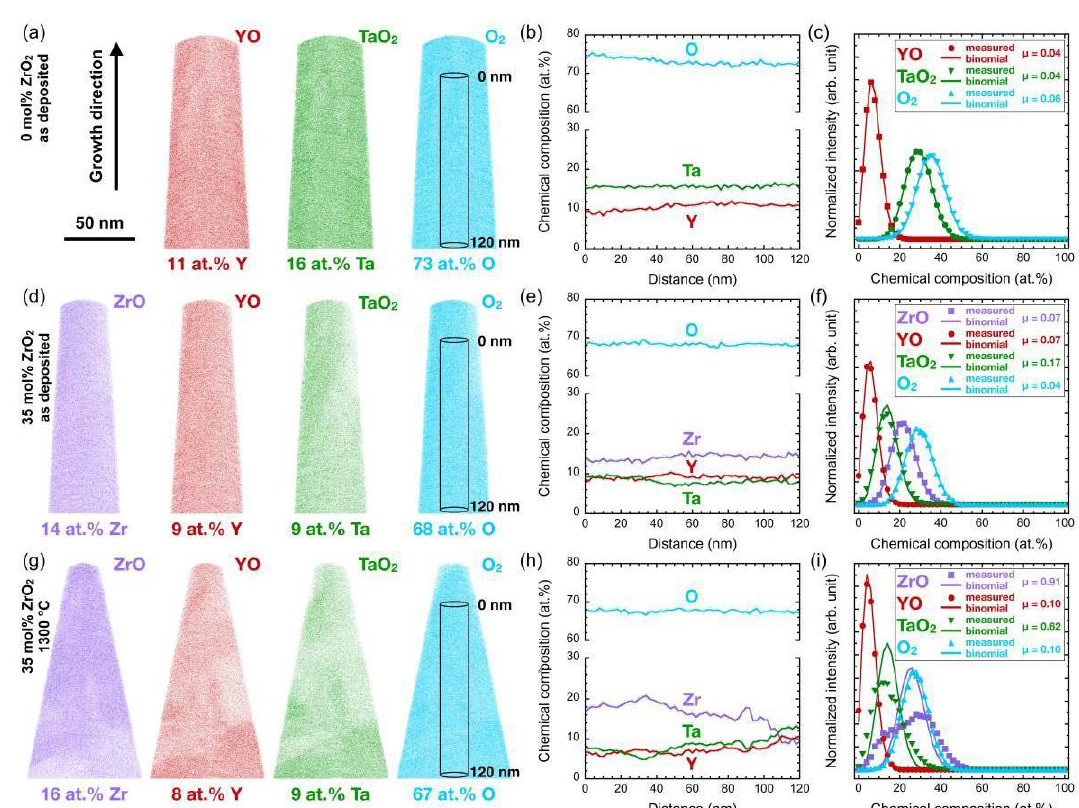
Figure 6. Spatially resolved chemical composition analysis by atom probe tomography (APT) of as-deposited samples with 0 mol% ZrO 2 ( a – c ) and 35 mol% ZrO 2 ( d – f ) as well as a sample with 35 mol% ZrO 2 annealed at 1300 °C ( g – i ); Reconstructions of molecular ions in ( a , d , g ) are provided as 20 nm slices with a length of 150 nm; Concentration profiles within cylinders indicated in ( a , d , g ) are shown in ( b , e , h ); Frequency distribution analyses with Pearson correlation coefficients µ are given in ( c , f , i ), and the measured distributions (data points) are compared to a random, binomial distribution (lines).